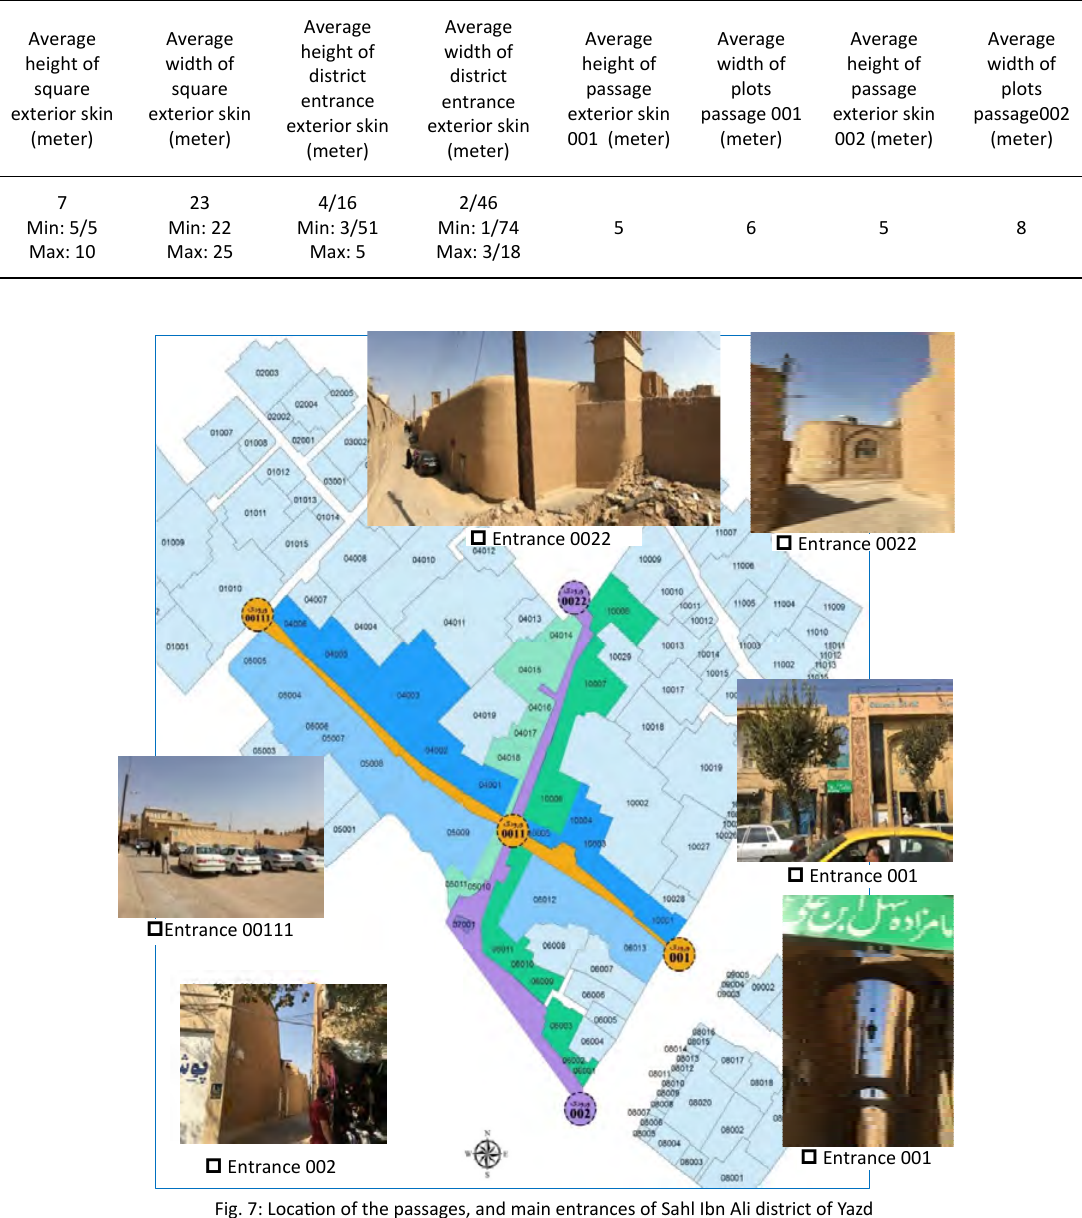
Table 1: Summary of the proportions of Shah Abolghasem exterior skin district of Yazd